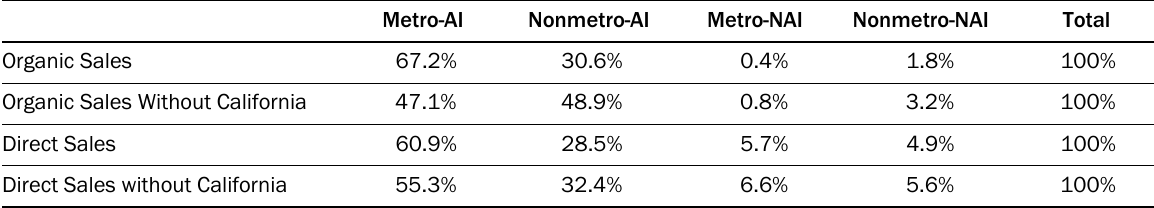
Table 6. Organic and Direct Sales by County Type With and Without California, 2007